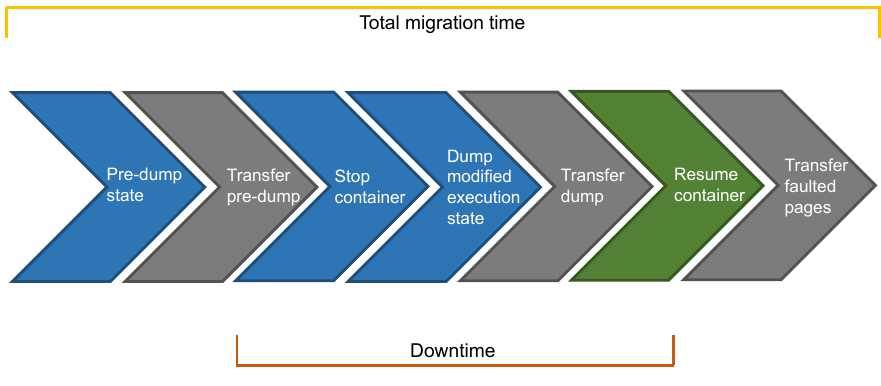
Figure 6. Hybrid